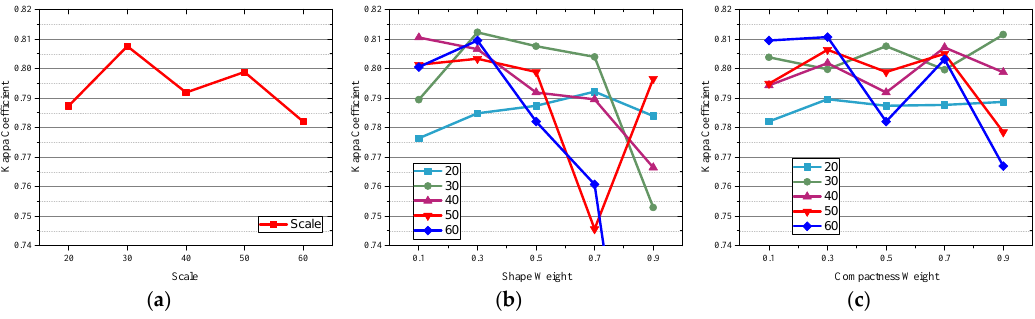
Figure 13. Parameter evaluation for ( a ) scale; ( b ) shape weight; and ( c ) compactness weight in test dataset